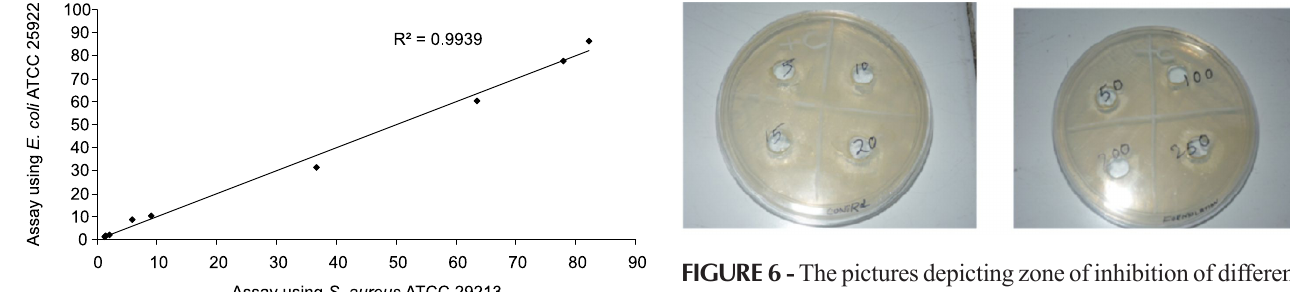
FIGURE 6 - The pictures depicting zone of inhibition of different standard dilutions of (1-250 µg/mL) against S. FIGURE 7 - The pictures depicting zone of inhibition of different standard dilutions of (1-250 µg/mL) against E. coli.